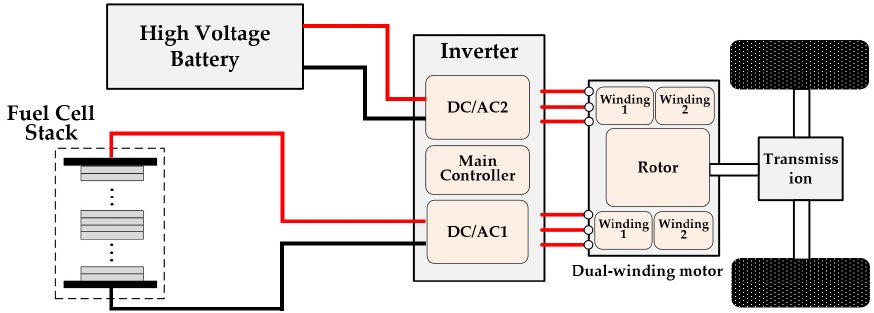
Figure 2. Schematic of the new drivetrain based on the dual-winding motor.